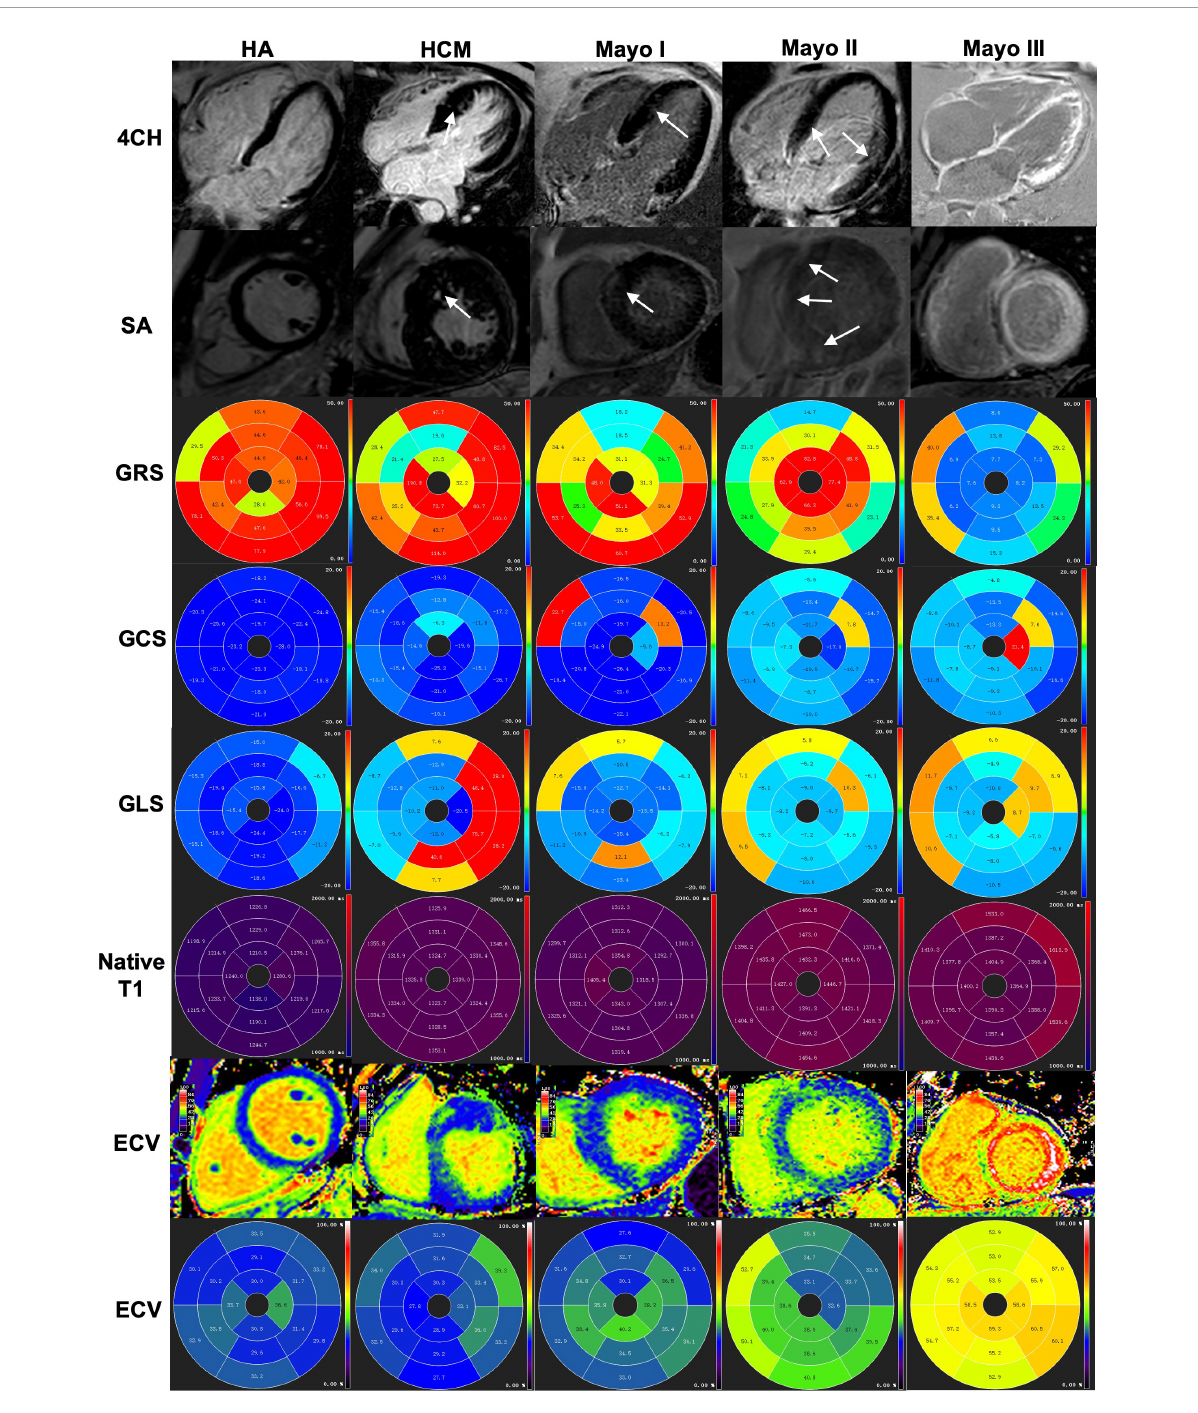
FIGURE3 A healthy control subject, an HCM patient and three different stages of AL amyloid patients were shown from left to right and index top to bottom (4CH, SA, GRS, GCS, GLS, native T1, ECV, and ECV bullseye, respectively. (Column 1) A healthy control subject without negative LGE and GRS (47.55%), GCS (–21.47%), GLS (–17.95%), normal T1 (1,251 ± 5 ms) and ECV (30.1 ± 2.1%) for the left ventricular. (Column 2) An HCM patient showed patch LGE and GRS (59.03%), GCS (–15.31%), GLS (–5.61), increased native T1 (1331 ± 8.1 ms) and ECV (31.1 ± 3.2%) for the left ventricular. (Column 3) An AL patient of Mayo I showed patchy LGE and GRS (31.82%), GCS (–18.31%), GLS (–10.67), increased native T1 (1,324 ± 21 ms) and ECV (36.4 ± 3.1%) for the left ventricular. (Column 4) An AL patient of Mayo II showed slightly diffuse LGE at the myocardium and GRS (25.79%), GCS (–15.84%), GLS (–7.13%), increased native T1 (1,422 ± 3 ms) and ECV (38.9 ± 3.5%) for the left ventricular. (Column 5) An AL patient of Mayo III showed global extensive LGE at the myocardium and GRS (10.13%), GCS (–8,88%), GLS (–7.09%), increased native T1 (1,421 ± 57 ms) and ECV (57.0 ± 4.6%) for the left ventricular. 4CH, four-chamber; SA, short axis; LV, left ventricular; LGE, late gadolinium enhancement; HCM, hypertrophic cardiomyopathy patients; GRS, global radial strain; GCS, global circumferential strain; GLS, global longitudinal strain; ECV, extracellular